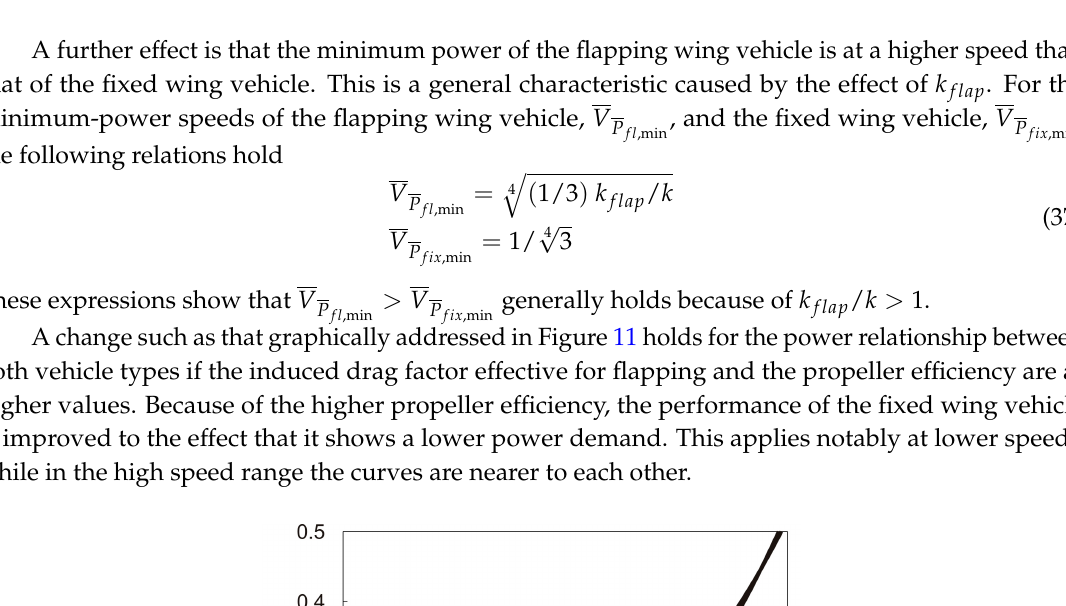
η ). k , 5.0 = prop flap